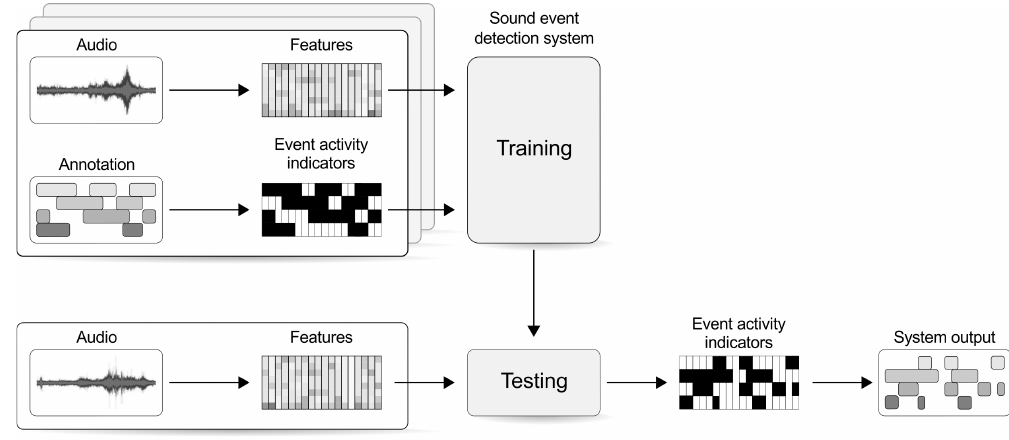
Figure 3. Sound event detection system